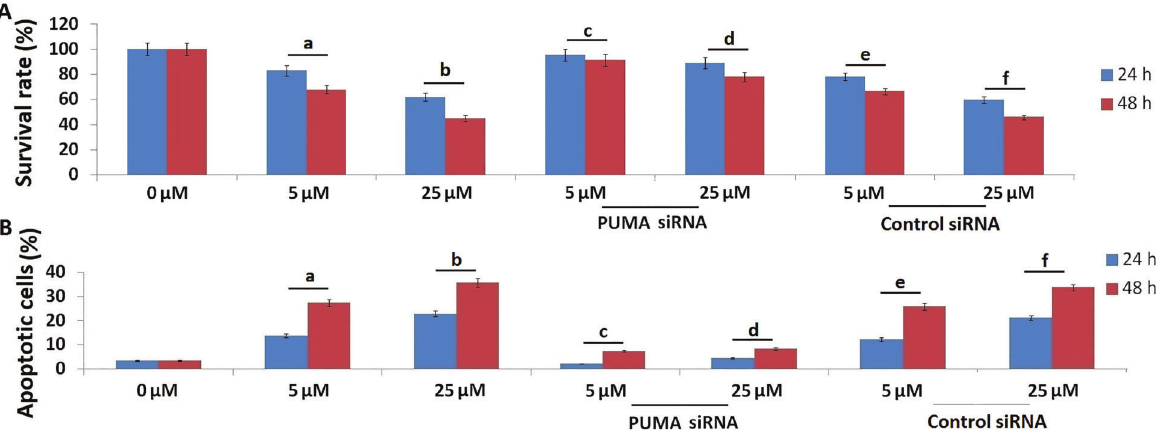
Figure 1. Benzyl isothiocyanate (5 and 25 m M) for 24 and 48 h induced apoptosis of SCC9 cells via p53-upregulated modulator of apoptosis (PUMA) signals. A , MTT was used to detect cell viability. B , Cell apoptosis was detected by FITC-conjugated annexin V/propidium iodide staining followed by fl ow cytometry. Data are reported as means ± SE. a P o 0.05, b P o 0.01 vs 0 m M; c P o 0.05 vs